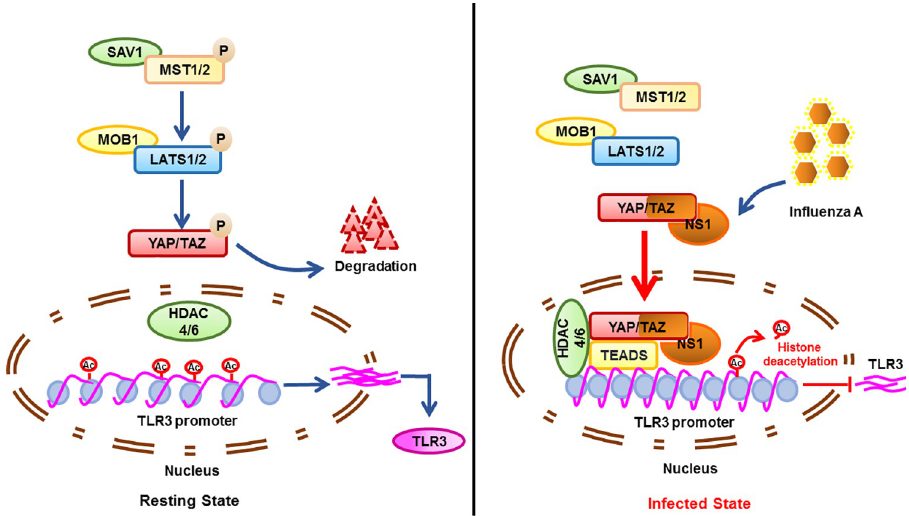
Fig 7. Molecular model depicts the mechanism of YAP/TAZ to antagonize TLR3-mediated innate immune signaling upon IAV infection. When the Hippo signaling is on, YAP/TAZ are restricted to the cytoplasm and targeted for degradation. TLR3 is consistently transcribed. Conversely, IAV infection leads the activation of YAP/TAZ and nuclear localization through direct protein-protein interactions between NS1 and the C-terminal TAD of YAP. YAP/ TAZ-TEADs complex functions as a transcriptional repressor to suppress the transcription of TLR3 by histone deacetylation at the specific promoter region through